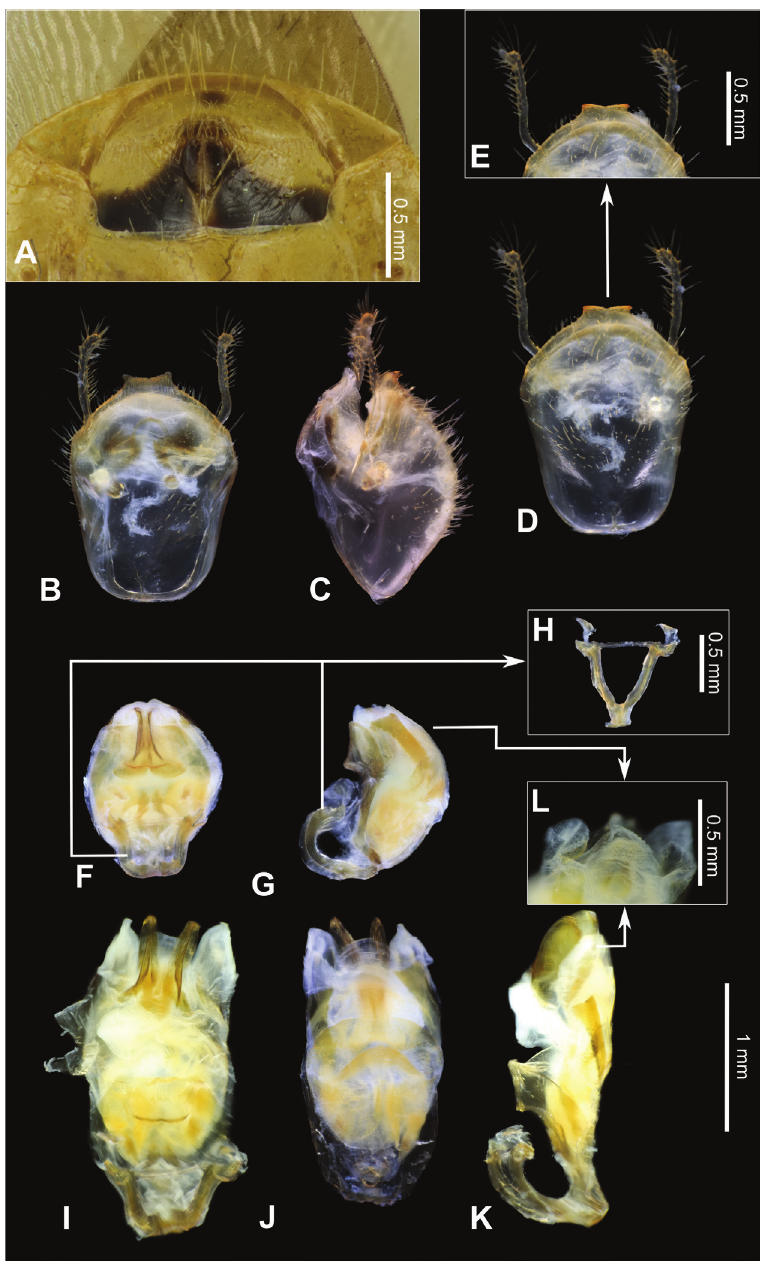
Figure 10. Biasticus flavus (Distant, 1903) A female genitalia in ventral view, ♀ , LA-Redu-2004-006 B–L male genitalia, paratype, ♂ , HEM-TH2004-018 B–E pygophore with parameres B dorsal view C lateral view D ventral view E apical portion of pygophore showing median process (mpp) and para- meres F–L phallus F dorsal view G lateral view H articulatory apparatus (aa) I phallus with endosoma semi-everted, dorsal view J aedeagus with endosoma semi-everted, ventral view K phallus with endosoma semi-everted, lateral view L distal dorsal lobe of endosoma